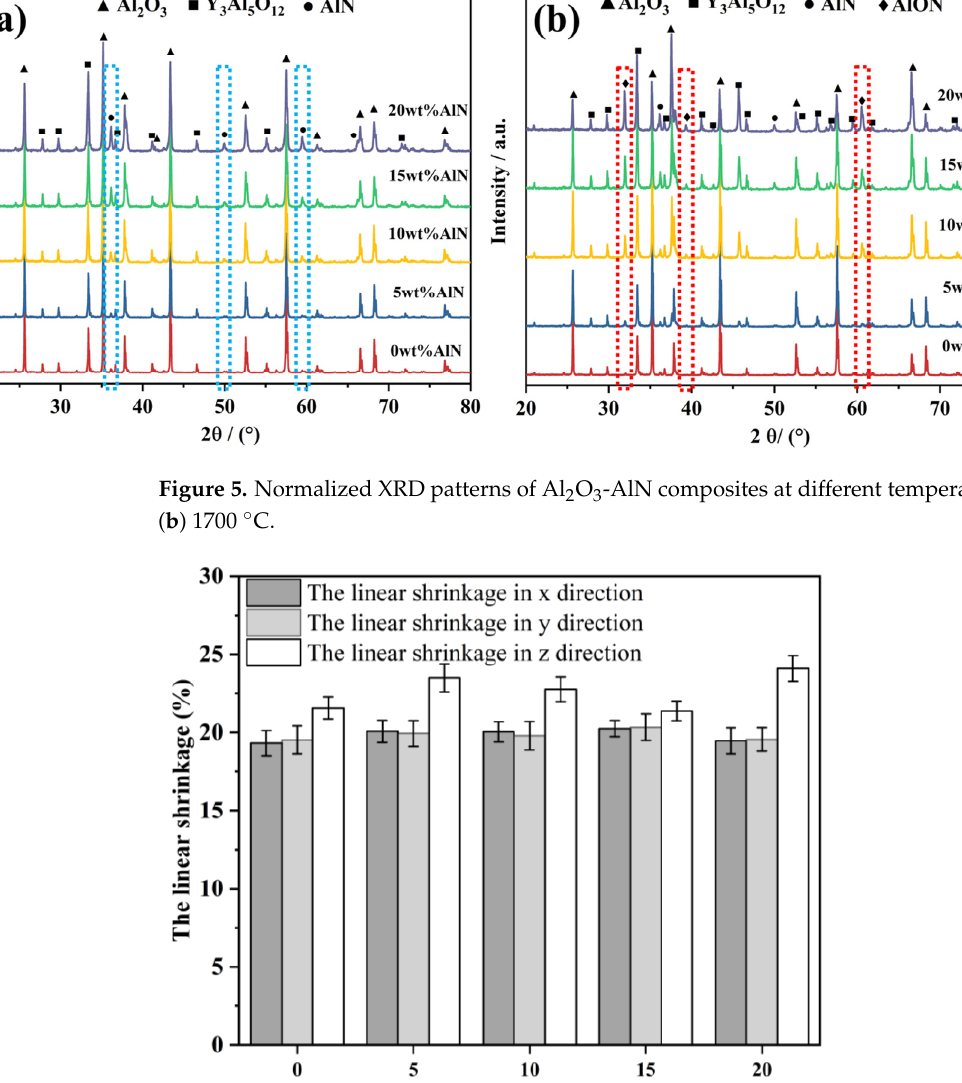
Figure 6. The linear shrinkage of sintering samples at 1650 °C with different AlN content. Table 2. The relative density of sintered samples at different